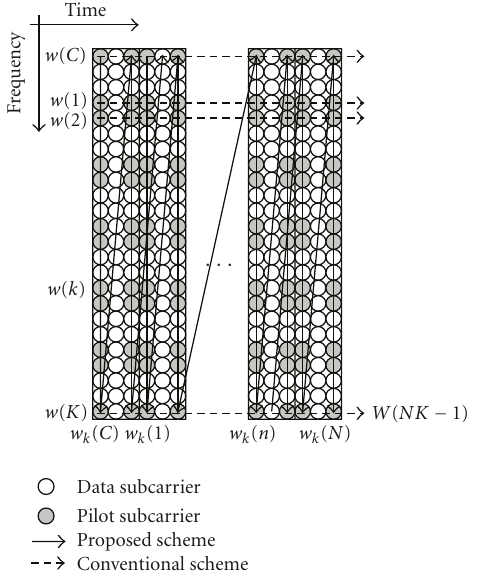
Figure 3: Calculation of autocorrelation matrix for the m-WiMAX SA system.